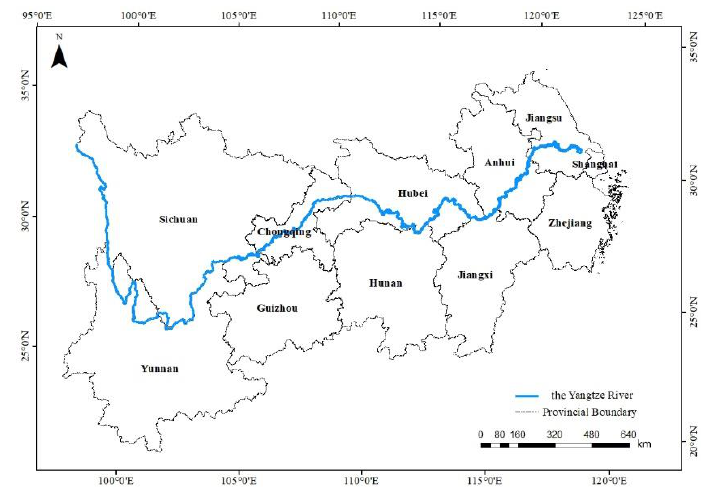
Figure 1. The location of the Yangtze River Economic Belt.